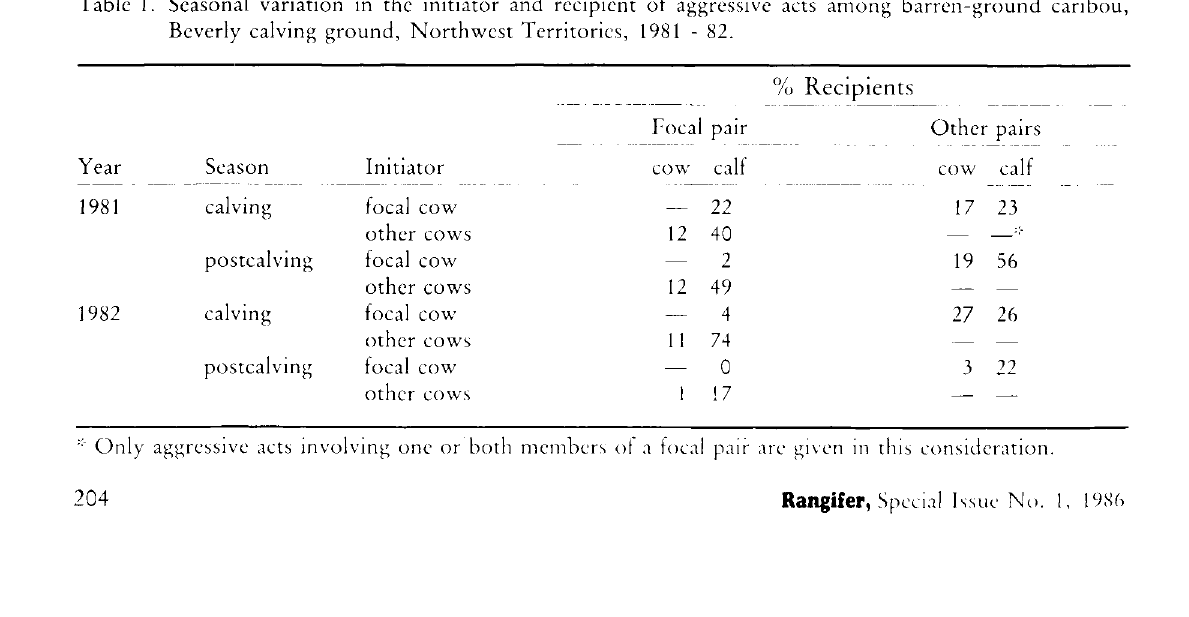
Table 1. Seasonal variation in the initiator and recipient of aggressive acts among barren-ground caribou, Beverly calving ; ground, Northwest Territories, 1981 -